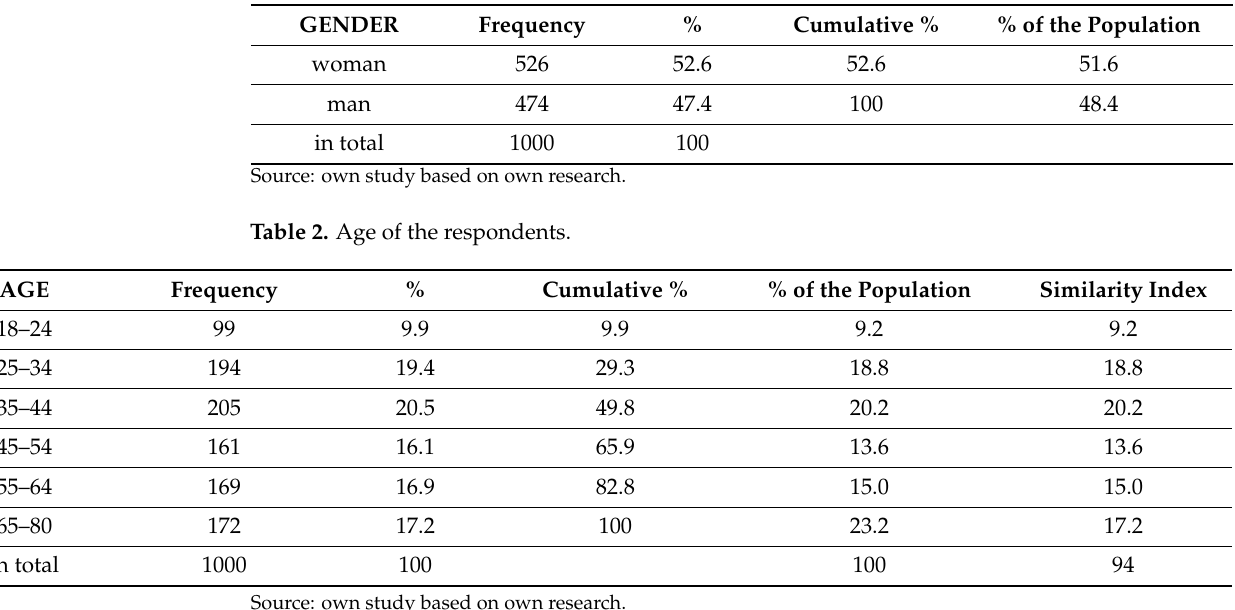
Table 1. Gender of the respondents.